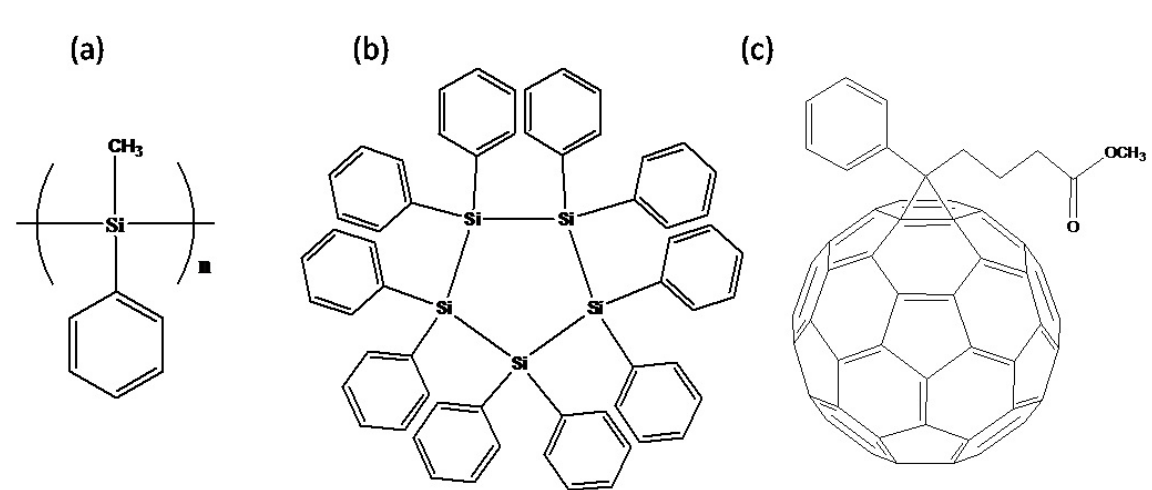
Figure 1. Atomic structures of (a) PMPS, (b) PDPS and (c) PCBM